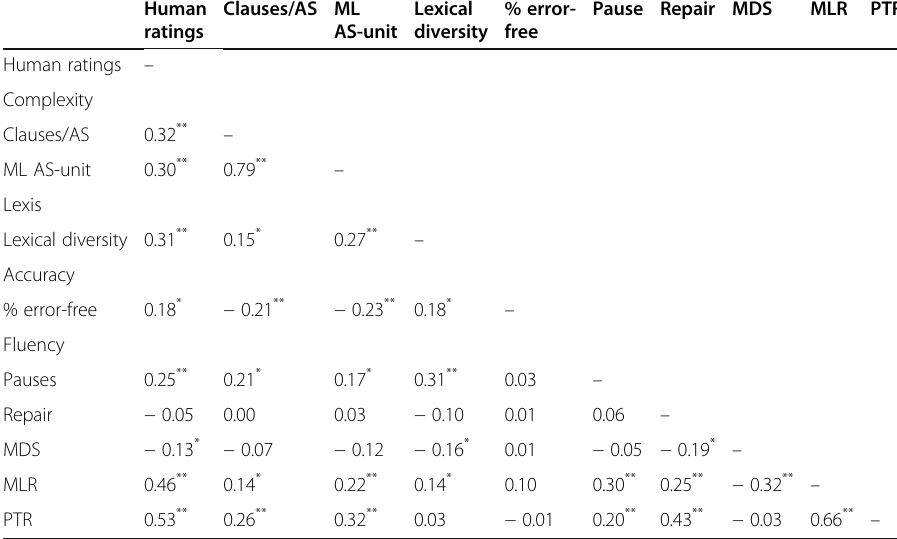
Table 8 Correlations among human ratings and CAF measures